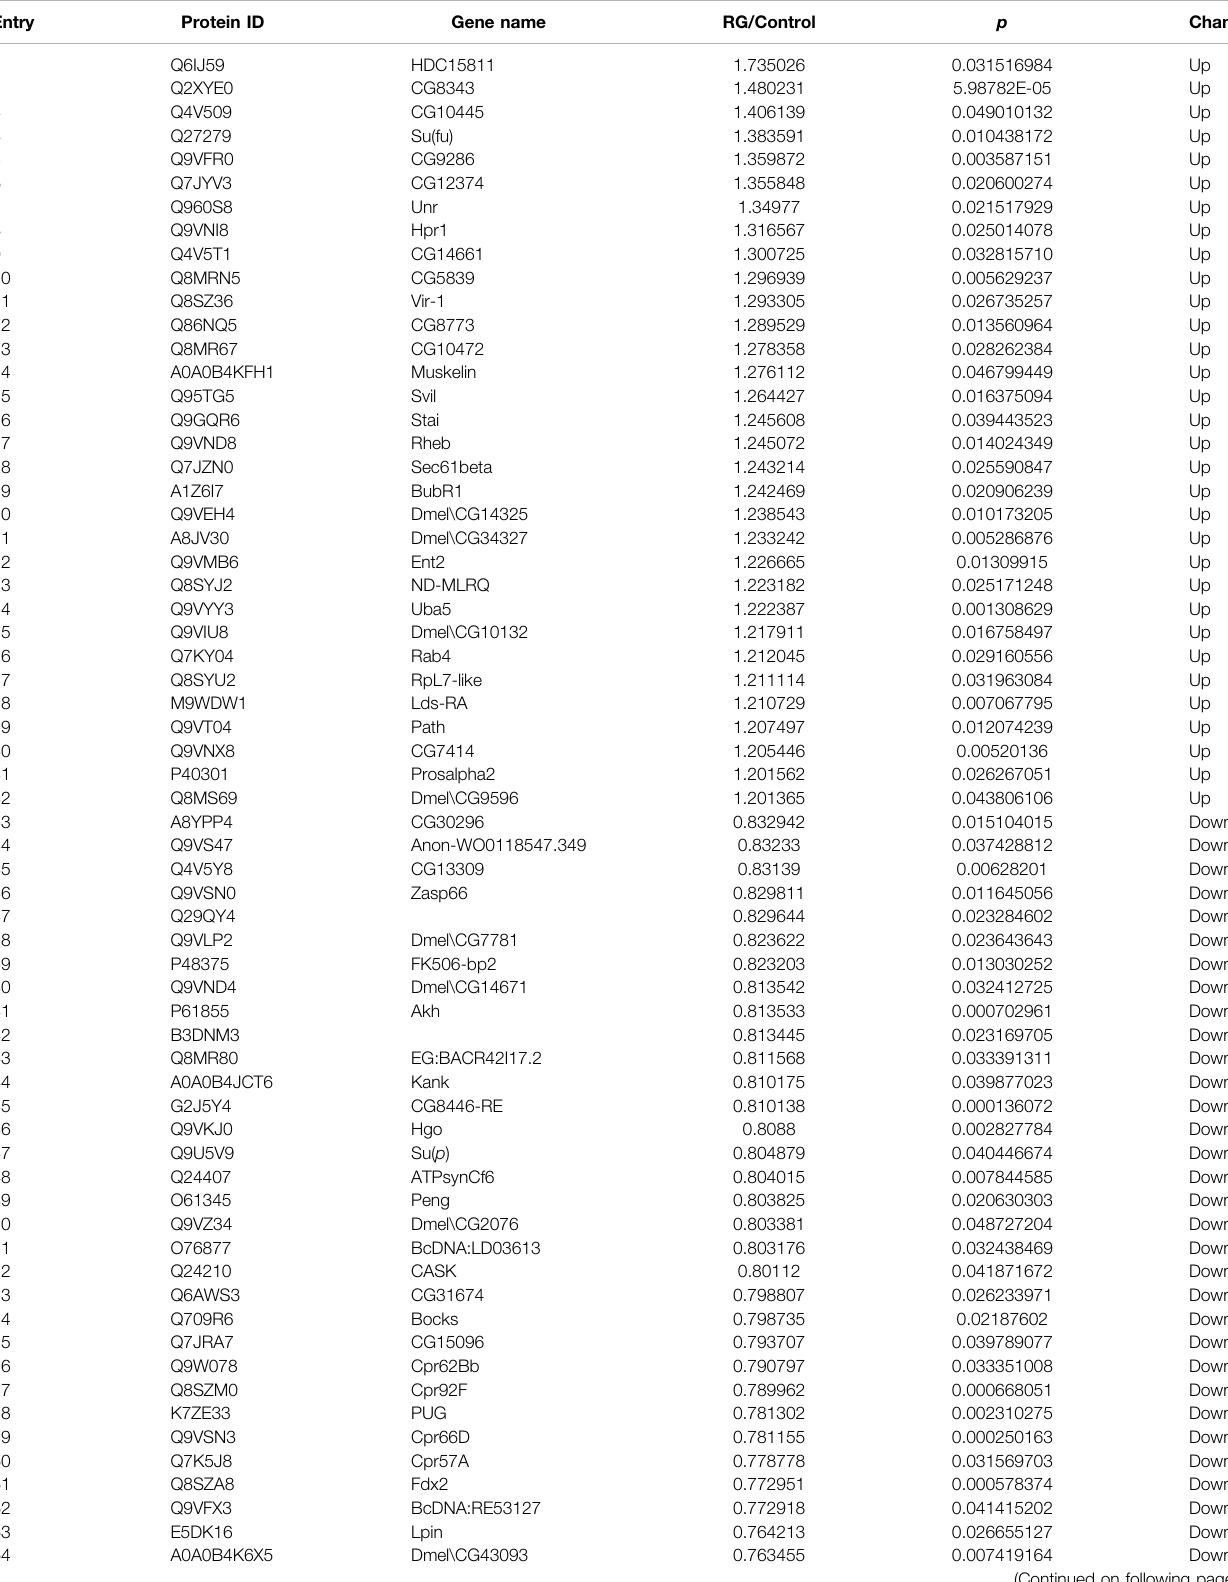
TABLE 2 | Identi fi cation of differential proteins in male D. melanogaster